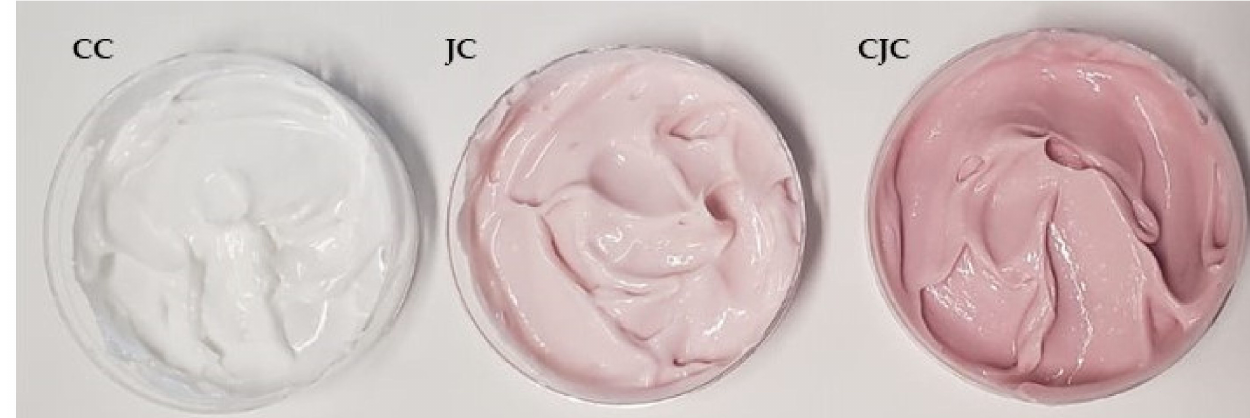
Figure 5. Formulation creams evaluated in this work. (CC) Control cream; (JC) juçara cream; and (CJC) concentrated juçara cream.